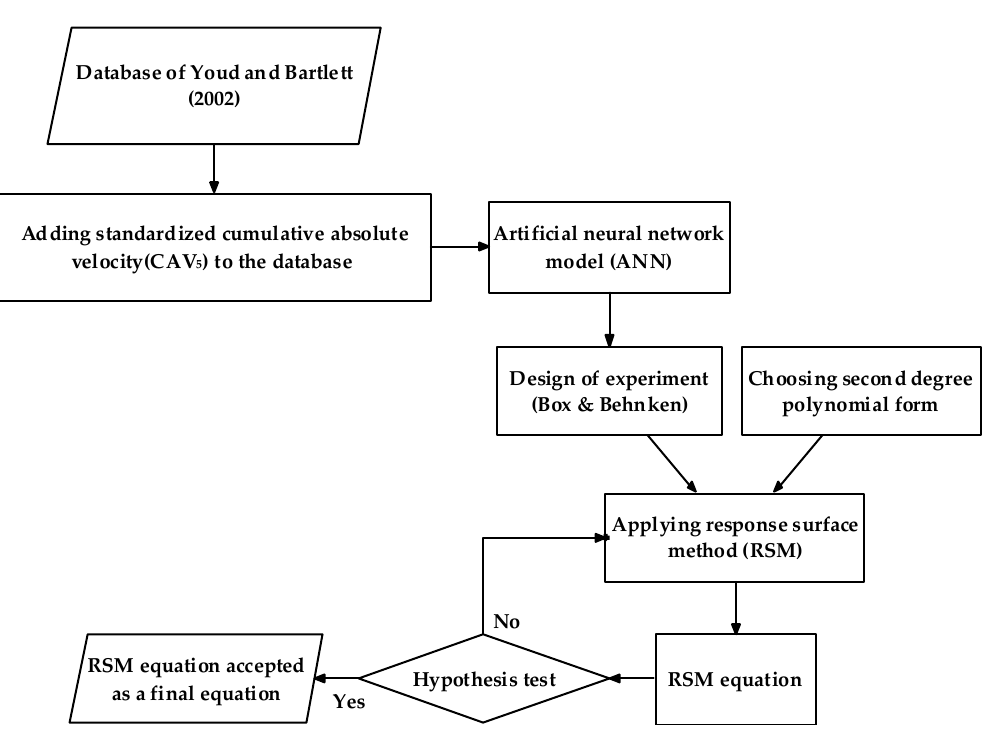
Figure 3. Flowchart of the approach applied in this study to present an equation to predict lateral displacement caused by displacement caused by liquefaction.